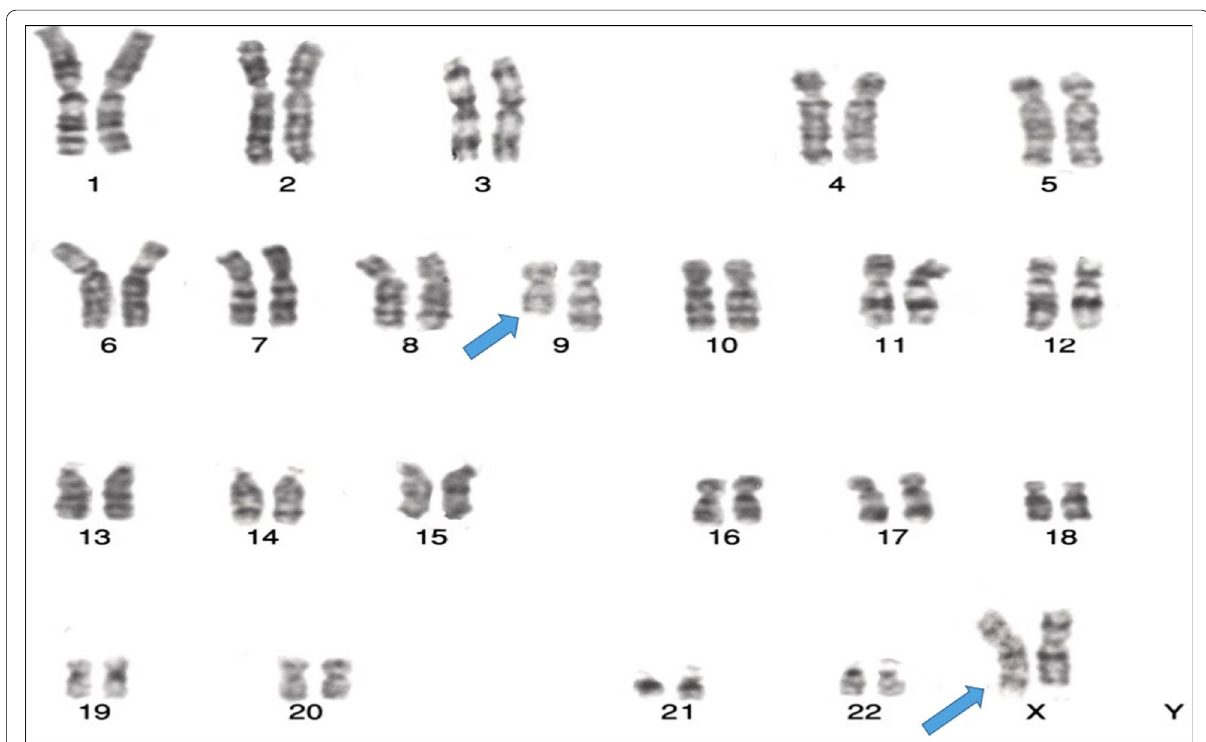
Fig. 2 Female karyotype with a reciprocal translocation between an X chromosome and a 9 chromosome with breakpoints at bands Xq26 and